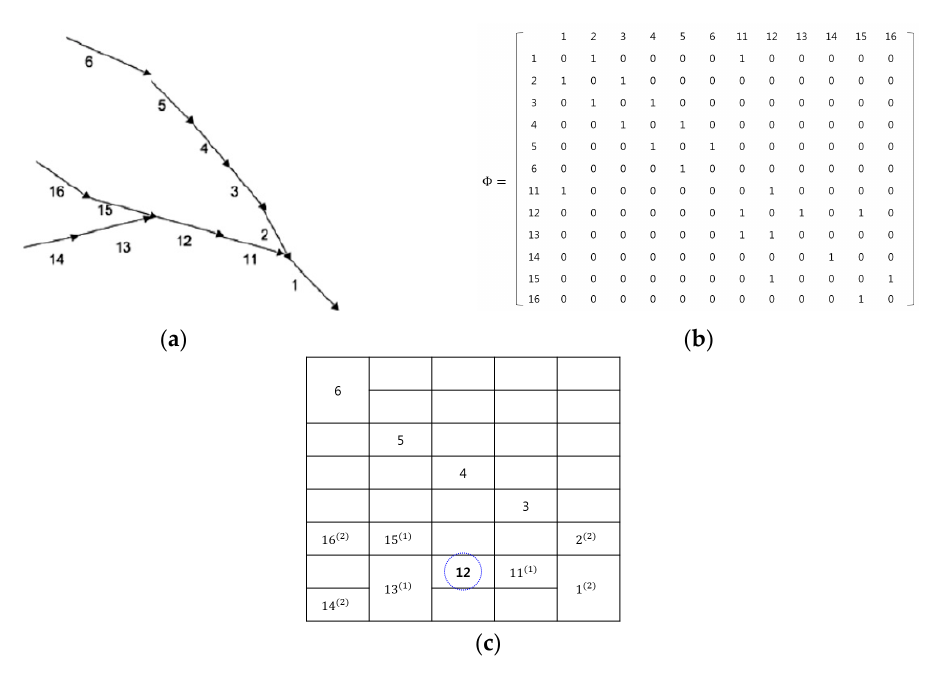
Figure 3. Example of map representations: ( a ) real map; ( b ) Wynter et al. ’s adjacency matrix; and ( c ) proposed heat map.